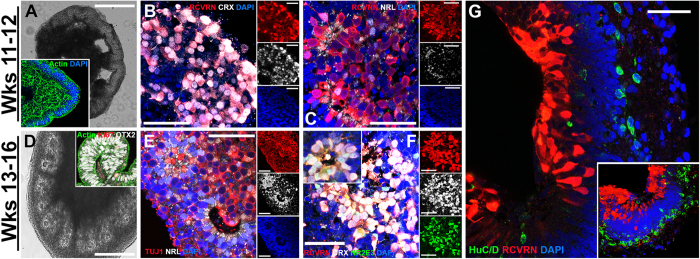
Development of clinical-grade photoreceptor precursor cells.Morphological and immunocytochemical analysis of 3D organoids after 11–12 and 13–16 weeks of differentiation. (A–C) After 11–12 weeks of differentiation, organoids have many areas of retinal-like folds (A; light micrograph) and retain highly organized F-actin-positive structures (inset in A; green). Organoids express the phototransduction molecule, recoverin (B; red) and the photoreceptor precursor-specific transcription factor, CRX (B; gray), a marker of committed photoreceptor precursor cells that is functionally downstream of OTX2 (Fig. 2). Some recoverin-positive cells within organoids at this stage also begin to express NRL, a rod photoreceptor-specific transcription factor (C; gray). Recoverin labeling can also be observed along neuronal-like processes of photoreceptor precursor cells. (D–G) Organoids after 13–16 weeks of differentiation are typically full of neural rosettes (D; light micrograph) and the majority of OTX2-positive cells (inset of D; gray) are now post-mitotic, Ki67-negative cells (inset of D; red). By this stage of development, many neuronal cells that are TUJ1-positive (E; red) are now positive for NRL (E; gray). Many recoverin-positive cells (F and inset; red) within neural rosettes co-express NRL (F and inset; gray) and NR2E3 (F and inset; green), which is functionally downstream of NRL in rod photoreceptor development and is transcriptionally regulated by NRL. Some organoids retain their lamination and resemble mature retina with independent layers of recoverin-positive photoreceptors (G; red) and HuC/D-positive inner retinal amacrine- and ganglion-like cells (G; green). 3D reconstrutction of a z-stack through a laminated eyecup further demonstrates the separate layers of photoreceptor-like cells and inner retinal neuron-like cells (G, inset). Small panels to the right of (B,C,E,F) show individual fluorophores. Scale bars A,D = 400 μm; B,C,E–G = 50 μm.